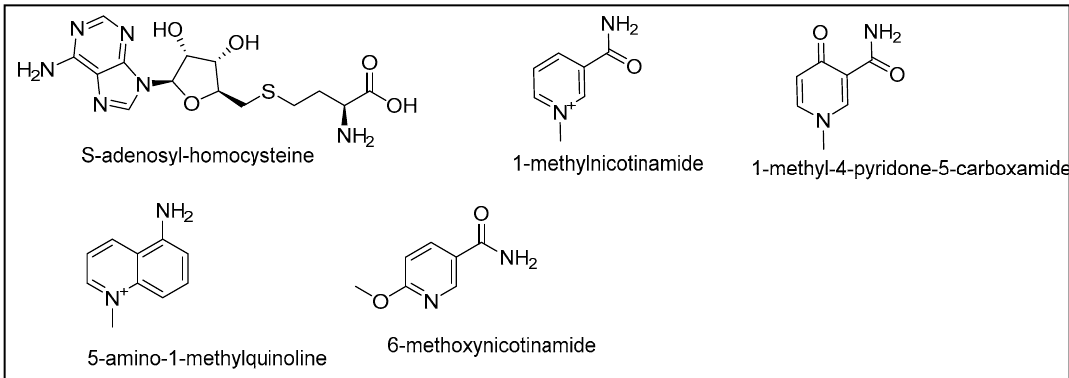
Figure 1. Known NNMT inhibitors.